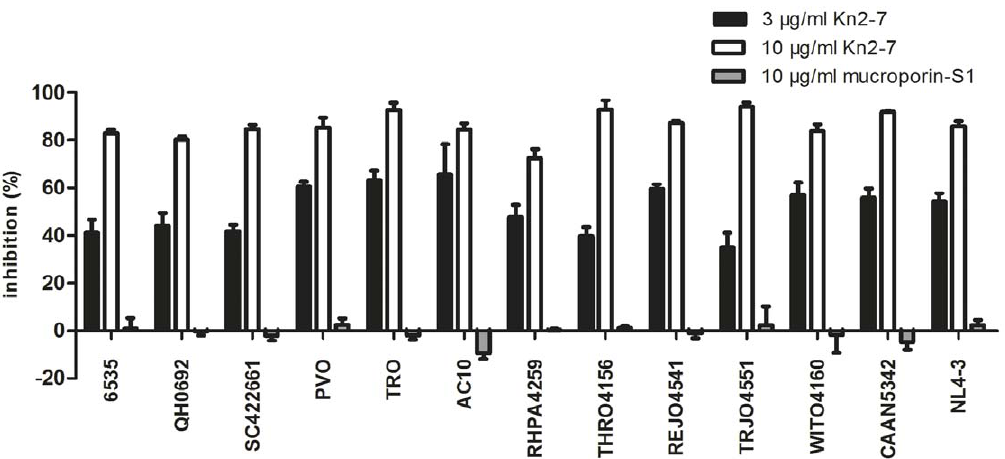
Figure 5. Broad-spectrum antiviral activity of Kn2-7 against 13 strains of HIV-1 subtype B PV. The inhibitory effect of the peptide was determined in TZM-bl luciferase detection system. Briefly, 3 m g/ml and 10 m g/ml of Kn2-7 was incubated with different strains of HIV-1 PV (200 TCID 50 ) for 1 h at 37 u C and then added to TZM-bl cells. The group treated with mucroporin-S1 and without any peptide in the same manner served as the negative and background control, respectively.